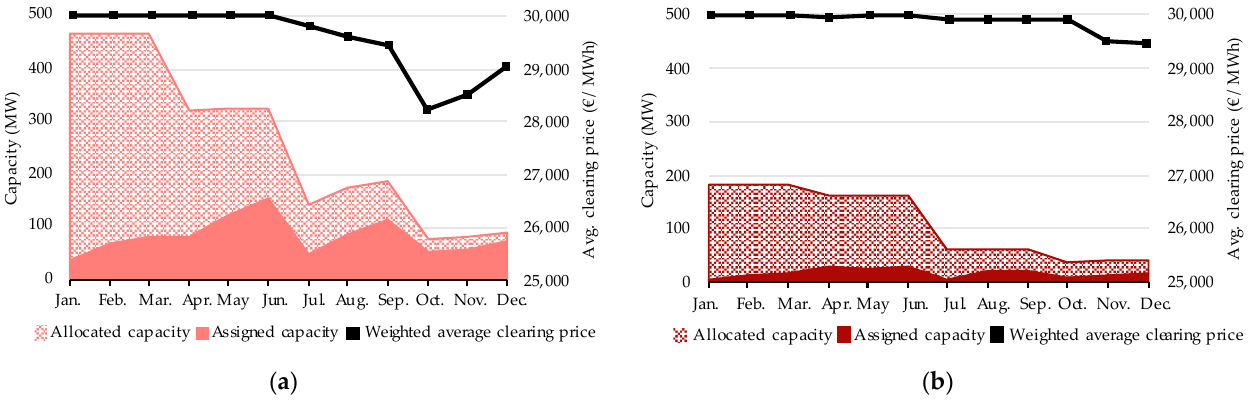
Jan. Feb. Mar. Apr. May Jun. Jul. Aug. Sep. Oct. Nov. Dec.